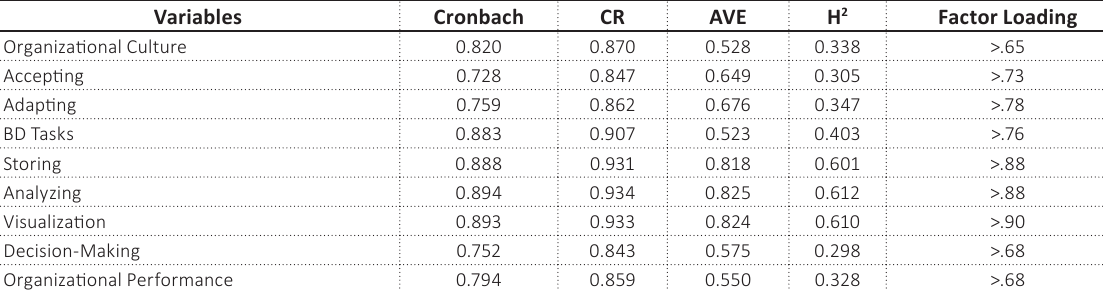
Figure 2. Measurement model highlighting factor Table 2. Measurement model assessment showing data validity